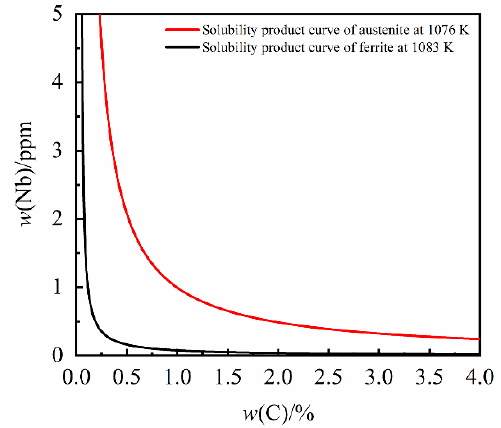
Figure 3. The solubility product curves of NbC in the solid phase.